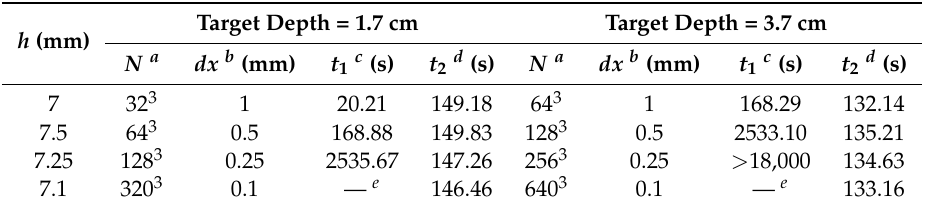
Table 6. Running time of k-Wave and the proposed method for the simulation of different skull thicknesses and two different target